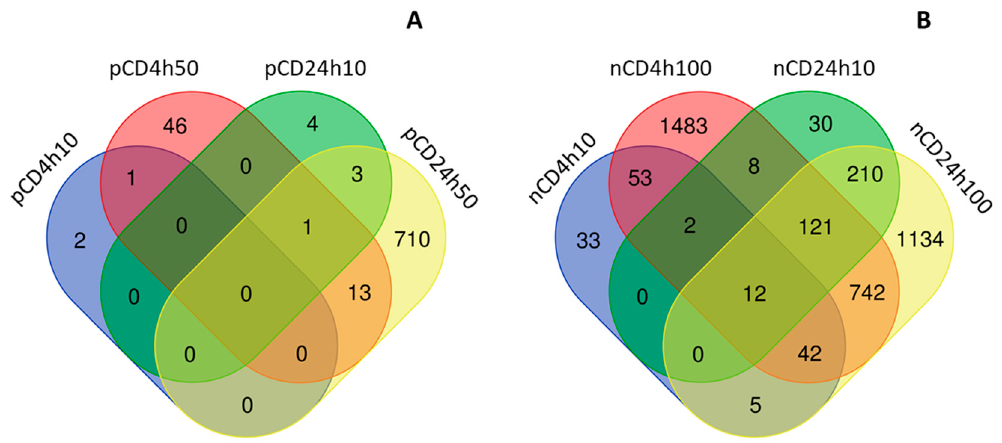
Figure 3. The distribution of common and unique mRNAs differentially expressed after CD NPs exposure; a comparison between doses and exposure times for pCD ( A ) and nCD ( B ).